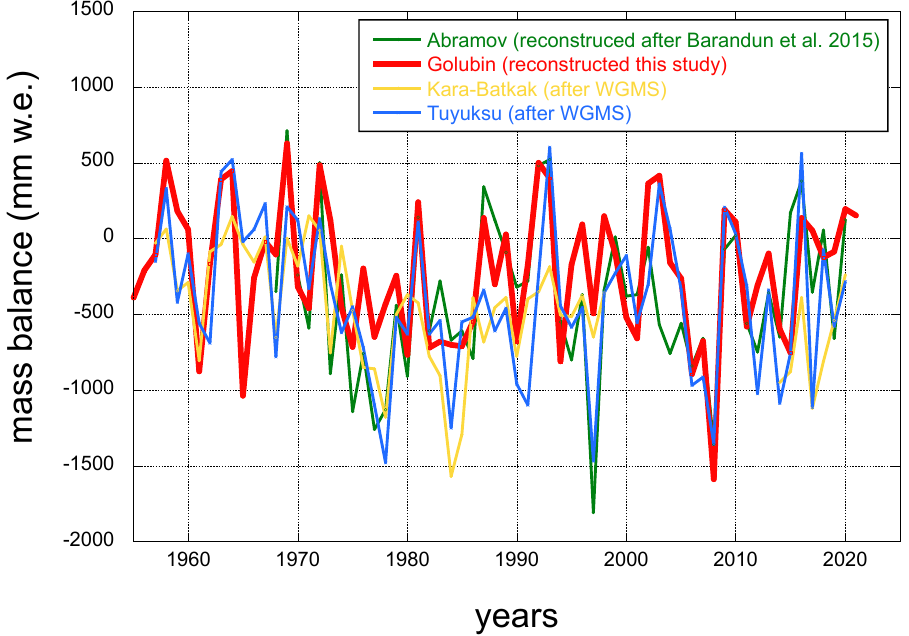
Figure 10. Comparison of measured and reconstructed mass balance of Golubin with measured mass balance of glaciers located in Tien Shan and